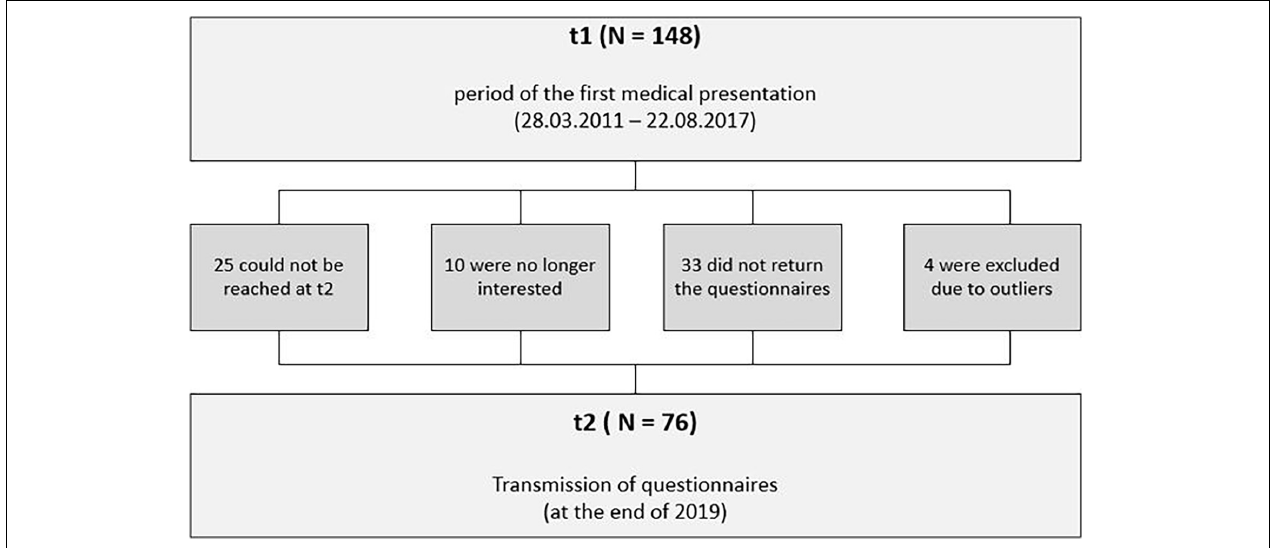
FIGURE 1 | Flow of